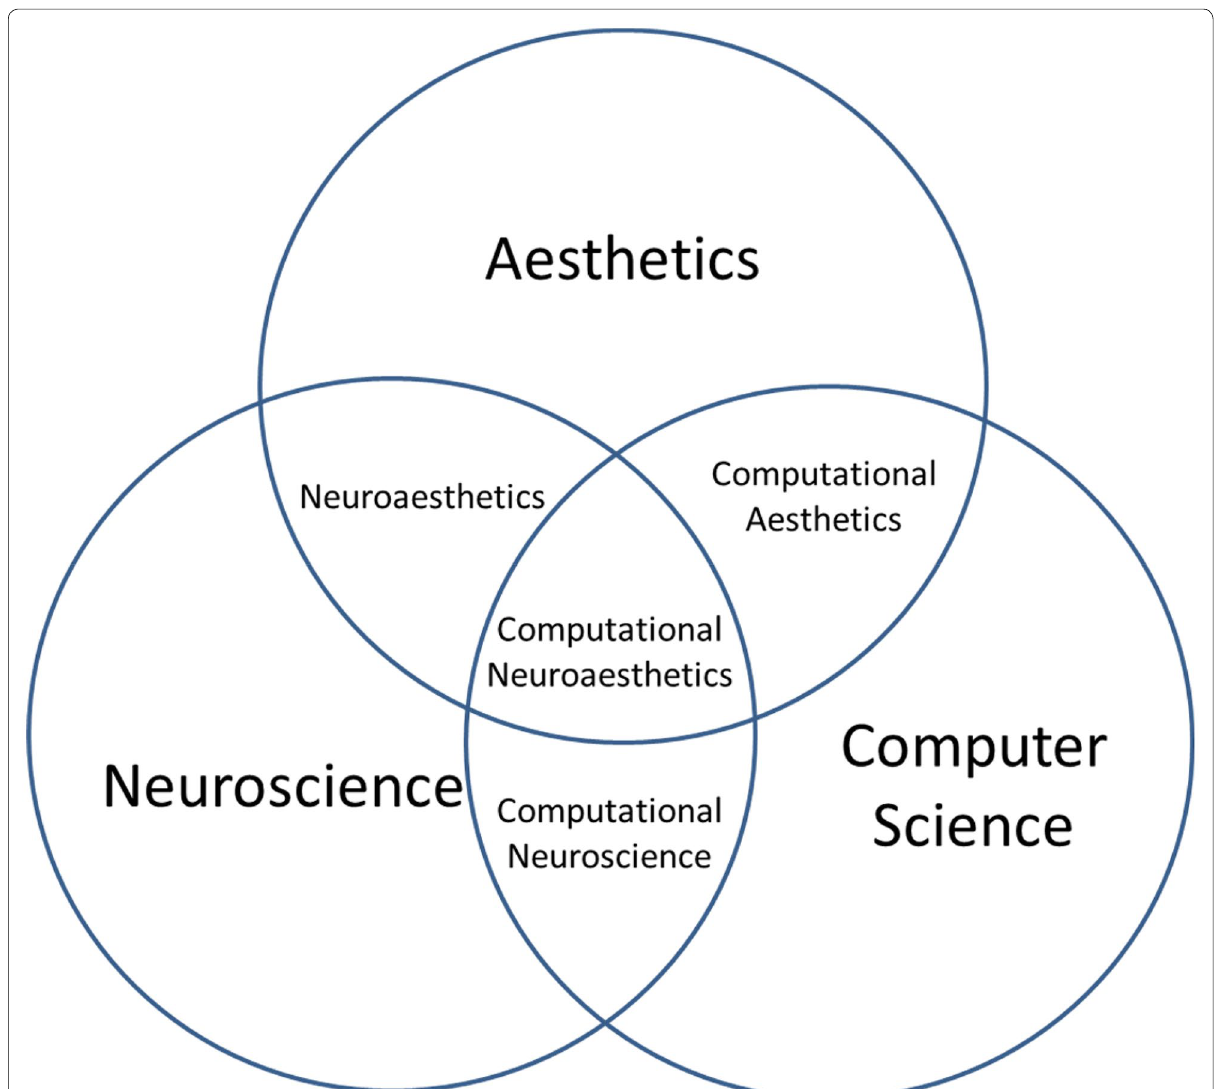
Fig. 1 Computational neuroaesthetics has emerged from three interdisciplinary fields: Neuroaesthetics which combines neuroscience and aesthetics, computational aesthetics which employs computer science to investigate aesthetics, and computational neuroscience which uses mathematical tools and theories to investigate brain